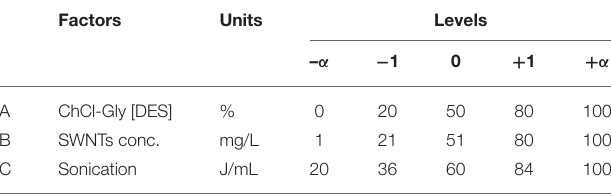
TABLE 1 | Experimental factors and their levels studied in central composite rotatable design (CCRD) of